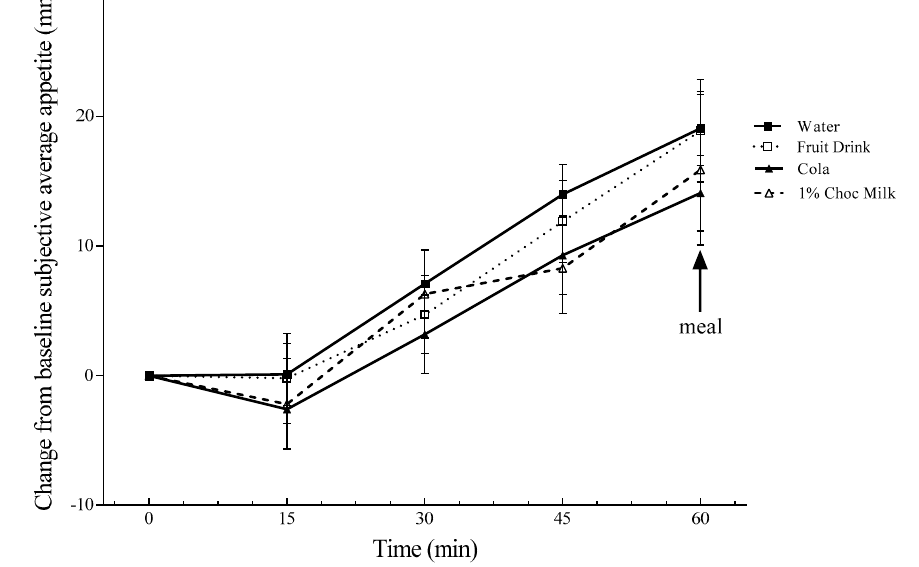
Figure 1. The change from the baseline subjective average appetite over 60 min. The values are mean ± SEM ( n = 32). The change from the baseline subjective average appetite was affected by time ( p < 0.001).